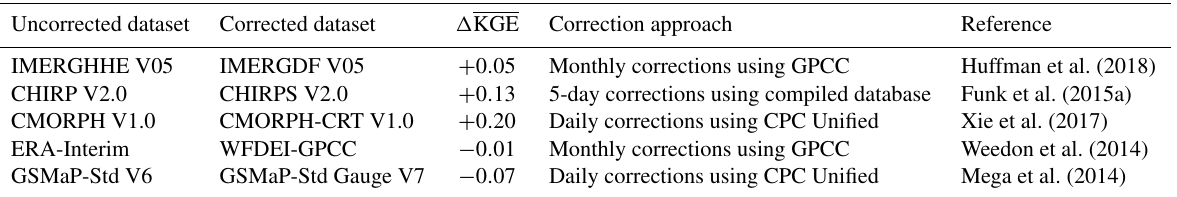
Figure 3. Box-and-whisker plots of KGE scores for summer (June–August) and winter (December–February) using the Stage-IV gauge- radar dataset as a reference. The circles represent the median value, the left and right edges of the box represent the 25th and 75th percentile values, respectively, while the “whiskers” represent the extreme values. The statistics were calculated for each dataset from the distribution of grid-cell KGE values (no area weighting was performed). The datasets are sorted in ascending order of the overall median KGE (see Fig. 2). Uncorrected datasets are indicated in blue, whereas gauge-corrected datasets are indicated in red. Details on the datasets are provided in Tables 1 and 2. Table 3. Difference in median KGE between uncorrected and gauge-corrected versions of P datasets. Tables 1 and 2 provide details of the